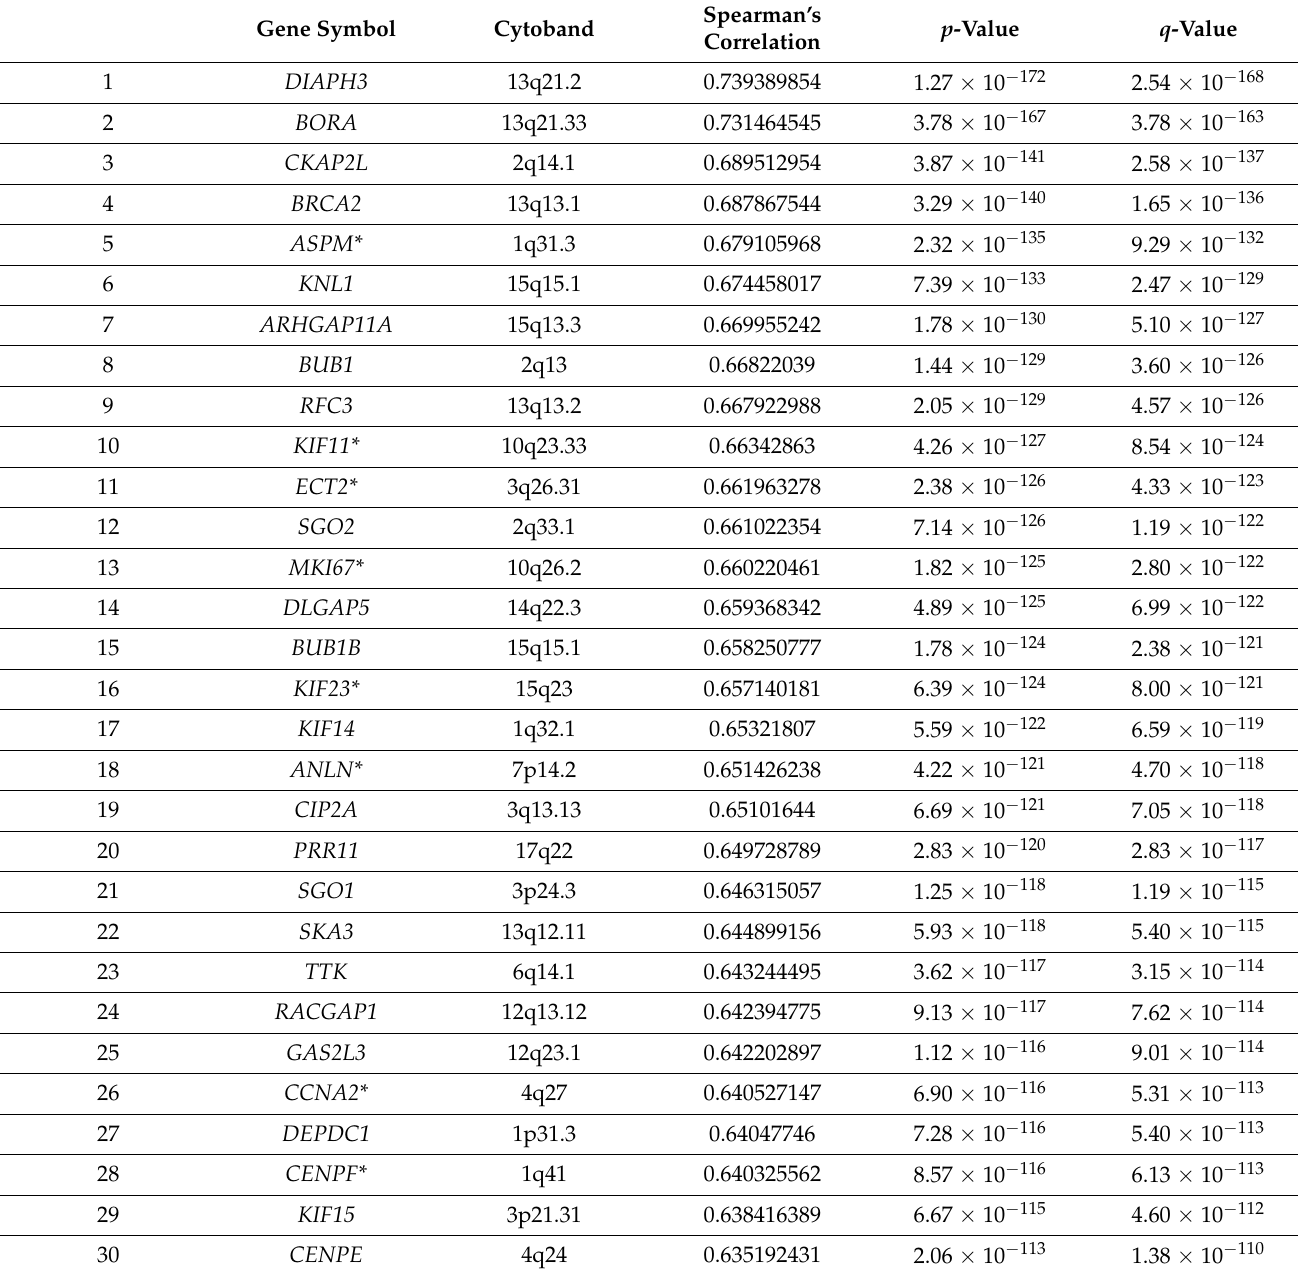
Table 5. Top 30 genes with highest Spearman’s correlation coefficient (r ≥ 0.5) predicted to co-express with CKAP2. Genes with an asterisk are also present in the list of 24 mitotically relevant genes. The q -value is derived from Benjamini–Hochberg FDR correction